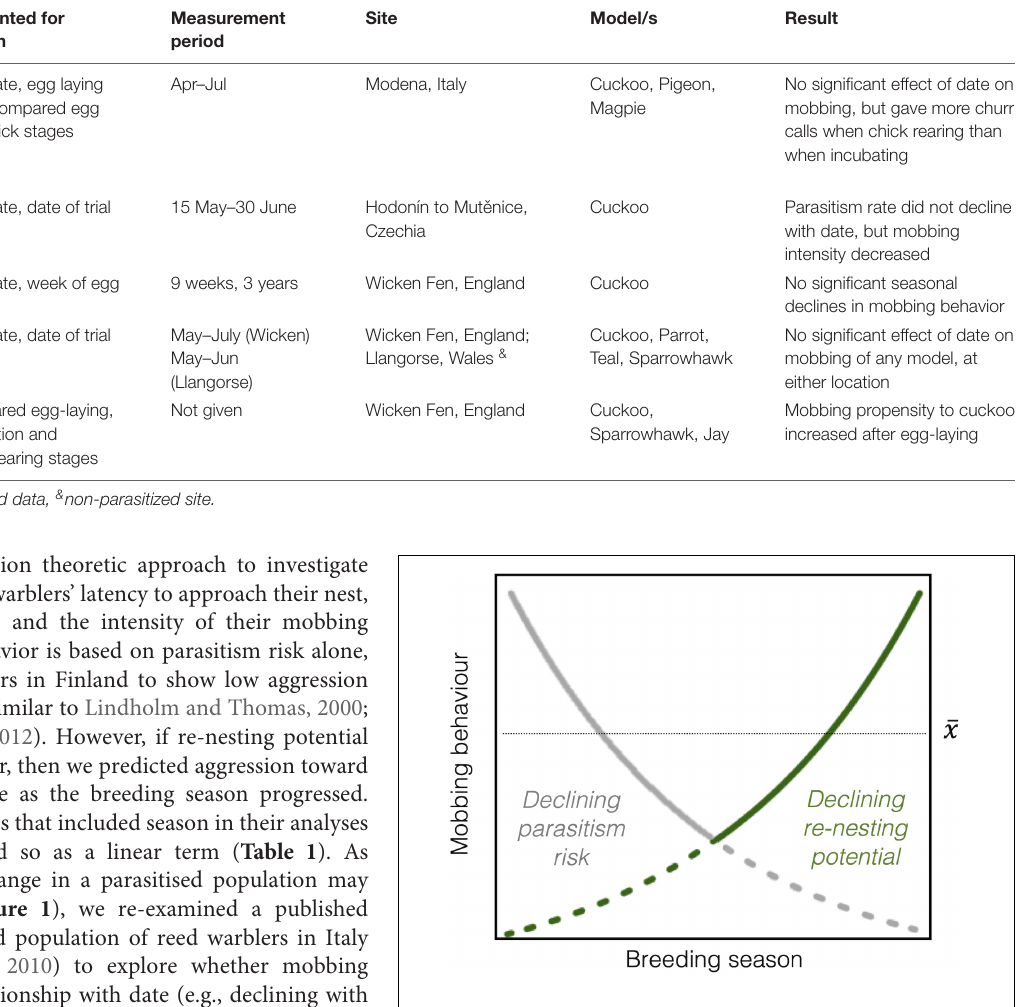
FIGURE 1 | Conceptual example of how changes in re-nesting potential (dark green line) over the breeding season could explain no overall seasonal change ( x , horizontal dotted line), or a quadratic change (solid lines), in mobbing behavior of hosts toward cuckoos, despite declining parasitism risk (dark gray line). Dashed lines indicate where the benefit of reducing mobbing is outweighed by the positive effect of either factor. Note that the shape of the detected seasonal relationship will depend on the relative strength and seasonal patterns of different